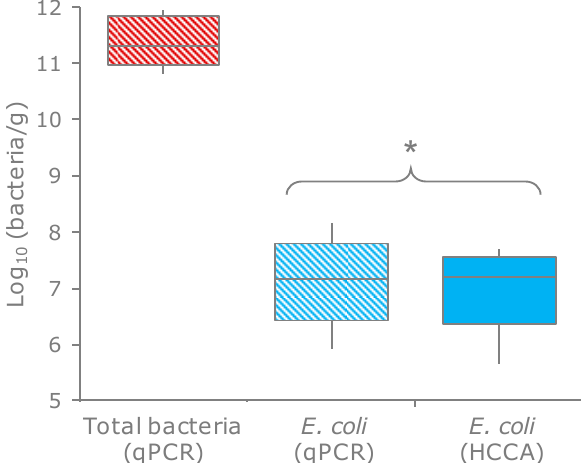
Figure 1. Counts of E. coli and total bacteria in the feces of 20 subjects. Boxes indicate the median and 25th and 75th percentiles; whiskers indicate the 10th and 90th percentiles. * indicates the means that did not significantly differ ( p > 0.05, paired samples t-test). HCCA, HiCrome Coliform Agar (the selective medium for E. coli ).